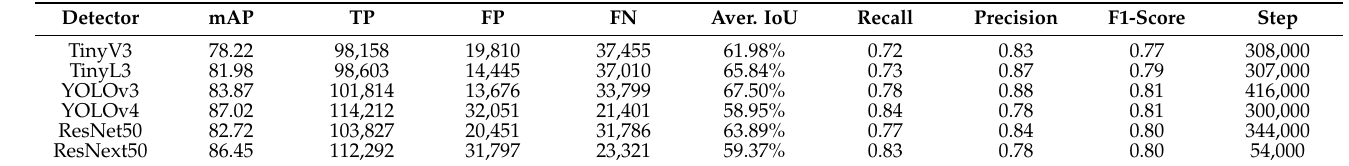
Table 4. Retrained results.